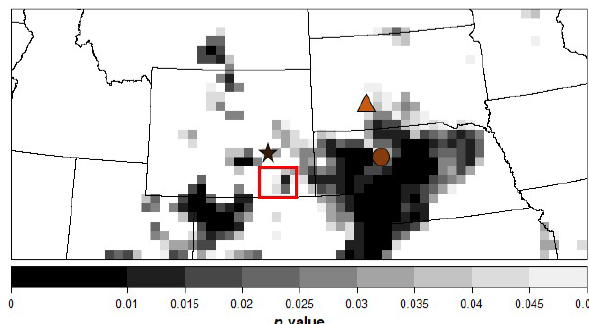
Figure 4. Map showing the spatial distribution of significant p val- ues ( p < 0 . 05) during the two case years (2002 and 2012) across the central Rocky Mountains and western Great Plains, USA. P values were evaluated using a two-tailed Student’s t test with an alpha of 0.05. Sedimentary proxy data from Long Lake, Wyoming (red box), as well as clusters of radiocarbon and luminescence dates from the Ferris and Casper dune fields (black star), the White River Badlands dunes (orange triangle), and the Nebraska Hills sand dunes (brown circle), all recorded severe drought conditions between ∼ 4200 and ∼ 4000calyrBP (Carter et al., 2017a; Stokes and Gaylord, 1993; Halfen et al., 2010; Rawling et al., 2003; Schmieder et al., 2011; Miao et al., 2007; Mason et al., 2004; 2011; Goble et al., 2004; Stokes and Swinehart, 1997; Loope et al., 1995; Ahlbrandt et al., 1983; Madole,